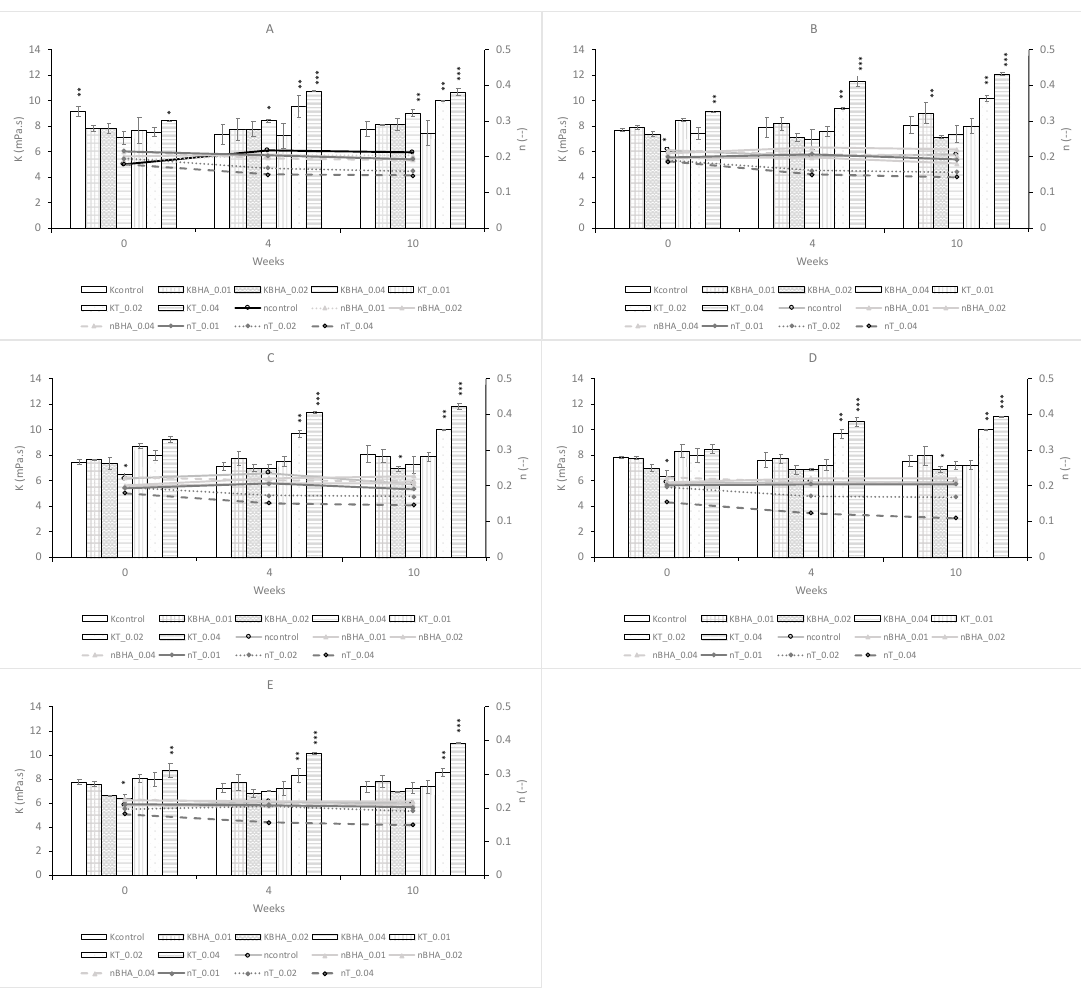
Figure 2. Effect of adding thyme extract and BHA, at different concentrations (0.01 %, 0.02 %, and 0.04 %) on rheological characterization, with determination of consistency index (Kc, KBHA, KT) and fluid behavior index (nc, nBHA, nT), under storage conditions (37 °C for 10 weeks). Bars mean standard deviation ( n = 4). Level of significance for the one-way ANOVA test: * P < 0.05 ; ** P < 0.01 ; *** P < 0.001. ( A ) 100% germ wheat oil and 0% almond oil. ( B ) 75% Germ wheat oil and 25% almond oil. ( C ) 50% Germ wheat oil and 50% almond oil. ( D ) 25% Germ wheat oil and 75% almond oil. ( E ) 0% Germ wheat oil and 100% almond oil.